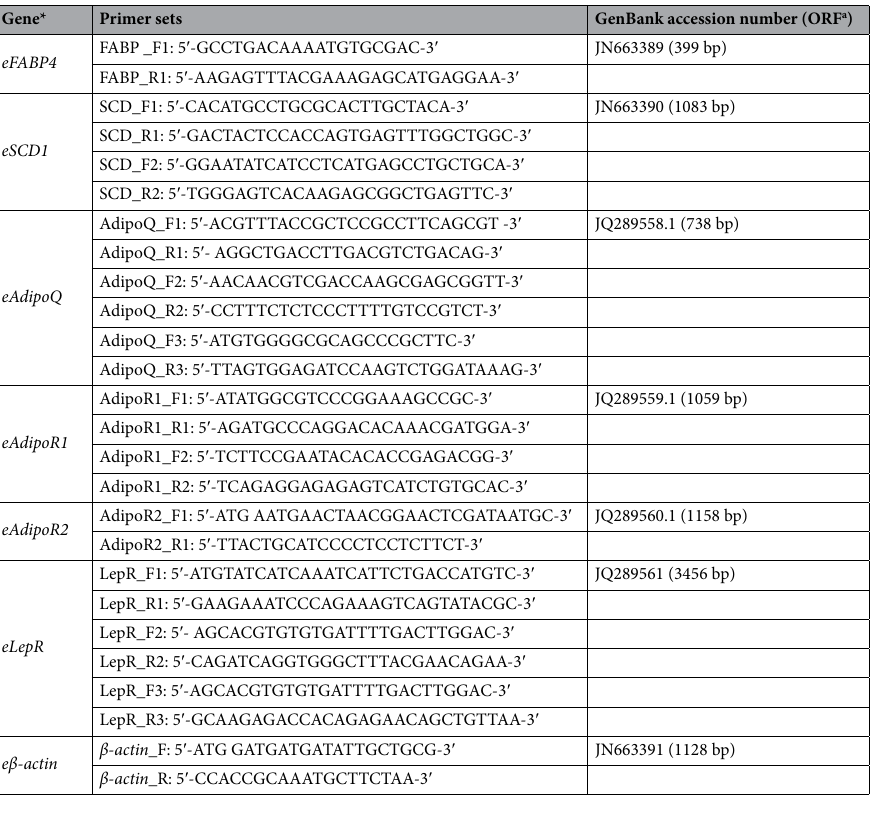
Table 1. Primers used for amplifying eFABP4 , eSCD1 , eAdopoQ , eAdipoR1 , eAdipoR2 , eLepR and eβ-actin from emu adipose tissue. *eFABP: emu Fatty Acid Binding Protein ; eSCD1: emu Stearoyl-CoA desaturase-1 ; eAdipoQ: emu Adiponectin ; eAdipoR1: emu Adiponectin Receptor1 ; eAdipoR2: emu Adiponectin Receptor2 ; eLepR: emu Leptin Receptor ; eβ-actin: emu beta-actin. a ORF Open reading frame.